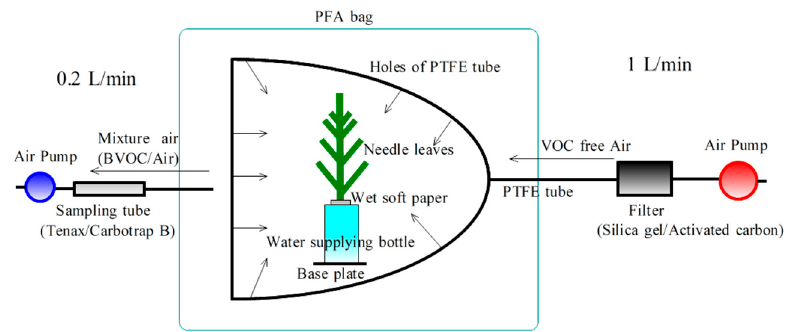
Figure 2. Branch enclosure method and sample.